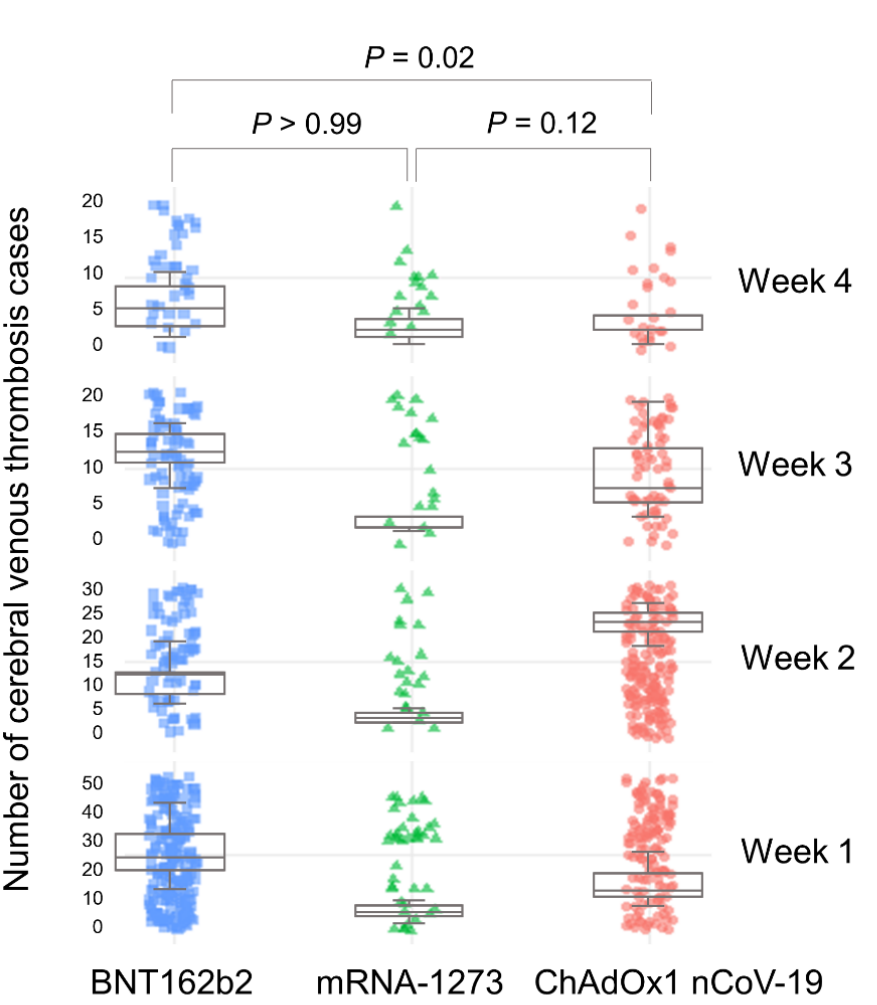
Figure 1. Differences between times of occurrence of cerebral venous thrombosis within 28 days after vaccine administration for each COVID-19 vaccine type. The box plots indicate median numbers of cerebral venous thrombosis cases and interquartile ranges per week depending on each vaccine. There are significant differences in time to cerebral venous sinus thrombosis onset from date of vaccination between the different vaccines within 28 days. In pairwise comparisons between vaccine groups, only significant differences between BNT162b2 and ChAdOx1 nCoV-19 vaccines remained ( p = 0.02).